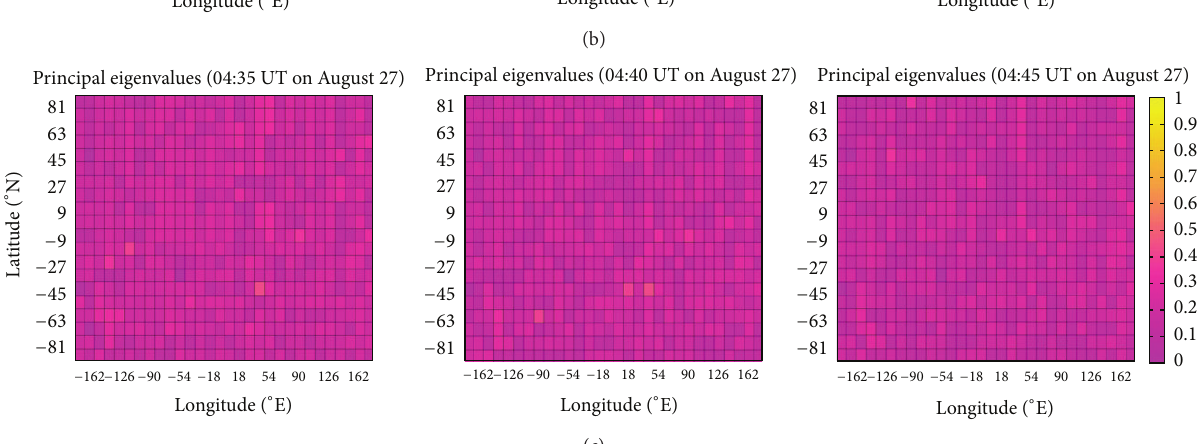
Figure 2: (a) The figures show the GIMs during the time period from 04:35 to 04:45 on 27August 2012 (UT). (b) The figures give a color- coded scale of the magnitudes of principal eigenvalues of 2DPCA corresponding to Figure 2(a). (c) The figures give a color-coded scale of the magnitudes of principal eigenvalues of PCA corresponding to Figure